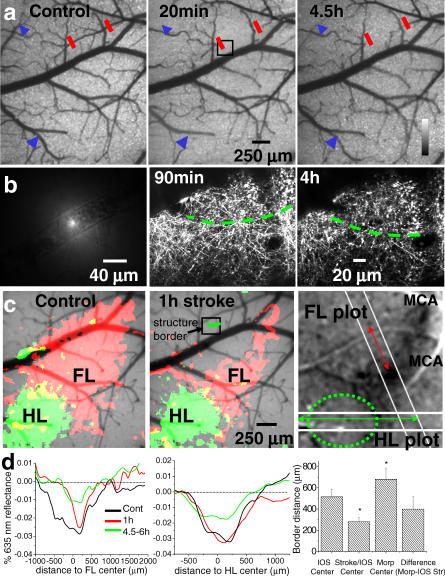
The Relationship between Loss of Dendritic Structure and Activity Dependent Hemodynamic Responses in Animals with Photothrombotic Stroke Targeted to Individual Arteries(A) Shown are laser-speckle surface blood flow images, darker tones indicate lower speckle contrast and higher velocities of blood flow. Left: control speckle contrast image of the right somatosensory cortex (oriented rostral up and medial left). A middle cerebral artery branch and sites where laser induced photothrombosis was performed are indicated by two red lines. Middle: 20 min after targeted photothrombosis blood flow has stopped in photoactivated segment. Blue arrowheads indicate changes in venous blood flow at distant sites. A small black box indicates the location of two-photon imaging shown in (B). Right: 4.5 h after stroke blood flow is still lost within the targeted MCA segment.(B) Image of RB photoactivation location on the MCA branch is indicated by the red line (left-most line). Upstream, to the right of the photoactivation spot a clot can be seen developing. Middle panel: dendritic damage border image taken 90 min after photothrombosis (approximate border indicated by a dashed green line, dendritic damage was reduced below the dashed line). Right: 4 h after photothrombosis dendritic damage worsened, although the approximate border for dendritic damage was in a similar location as that observed at the 90-min timepoint (note the structural transition and some intact dendrites in the lower part of the image).(C) Left: IOS map of contralateral forelimb (FL) and hindlimb (HL) responsive areas (average of 40 trials). Middle: 1 h after stroke the forelimb map has retreated while the hindlimb map is largely preserved (average of 40 trials collected 30–60 min poststroke). Right: raw image of change in reflectance for the 1 h poststroke contralateral forelimb map (images scaled from −0.05% to 0.05% change). The white diagonal and horizontal lines indicate the size and location used for determining response profiles in (D). The locations of MCA branches activated by forelimb stimulation are indicated; the arteries are clearly visible as lighter structures.(D) Quantification of forelimb and hindlimb IOS response from smoothed line profiles indicated in (C) (right). The profiles show a large change in the border of the forelimb territory (left). For the 1-h maps the edge of blebbed dendritic structure was 511 μm from the edge of the forelimb response. The hindlimb functional border was largely unaffected (middle panel). The approximate border locations for IOS responses were maintained for both 1- and 4.5–6-h timepoints. Right: average group data from nine different animals showing distance between the IOS map border and the center of the map for control conditions (column 1) and after stroke (column 2). The distance between the border of morphological dendritic damage and the center of the IOS map is in the third column. The last bar is the difference between bars 2 and 3 for each animal; a measure of the distance between the morphological edge of stroke damage and edge of the IOS response after stroke. Paired t-tests compared column 1 to 2 or 3 (asterisks indicate p < 0.02, alpha reduced since two comparisons were performed).